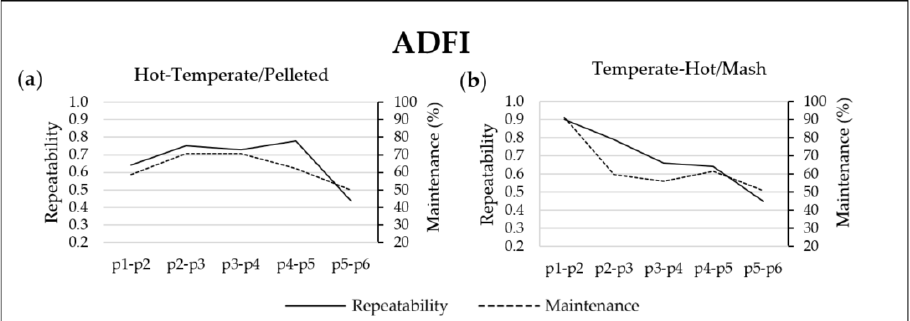
Figure 1. Repeatability (left axis) and maintenance (right axis) of the average daily feed intake (ADFI)